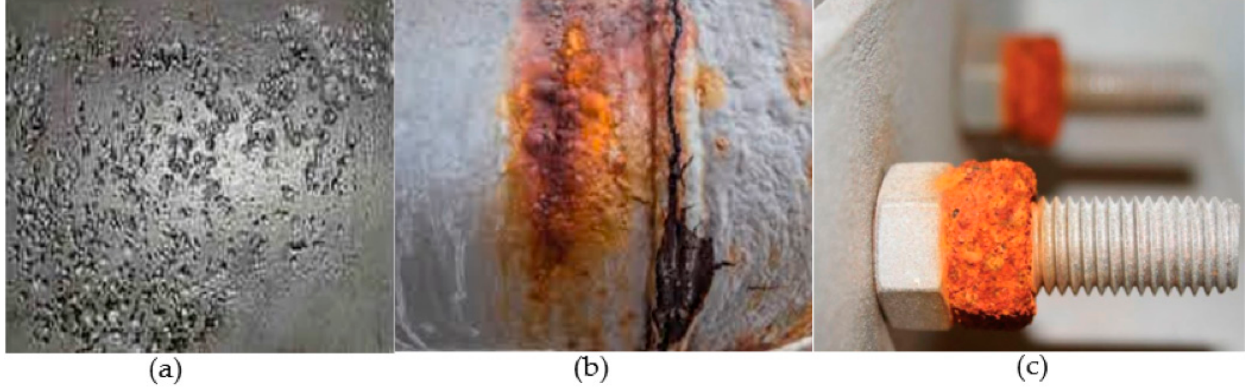
Figure 8. ( a ) Pitting corrosion in carbon steel [109]; ( b ) stress crack corrosion on carbon steel [110]; ( c ) crevice corrosion on a bolt [111].